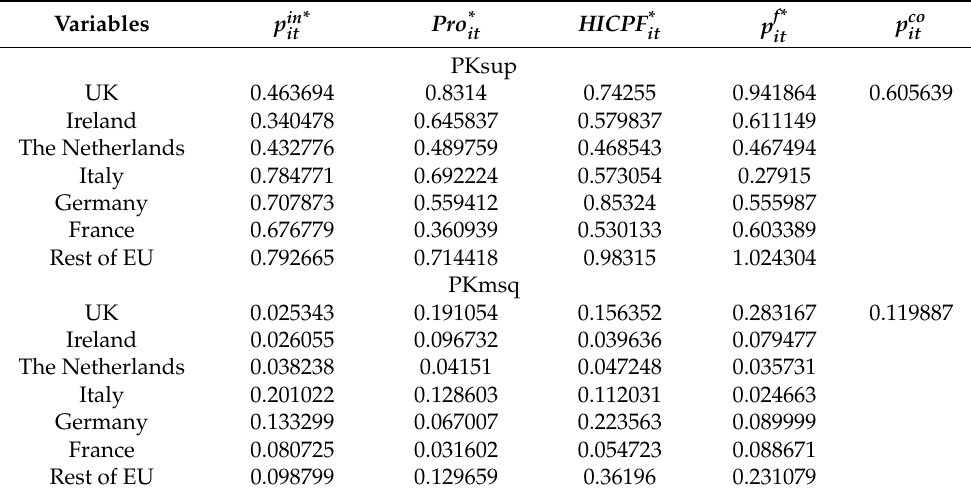
Table A1. Structural stability tests for intra-EU GVECM: statistics.